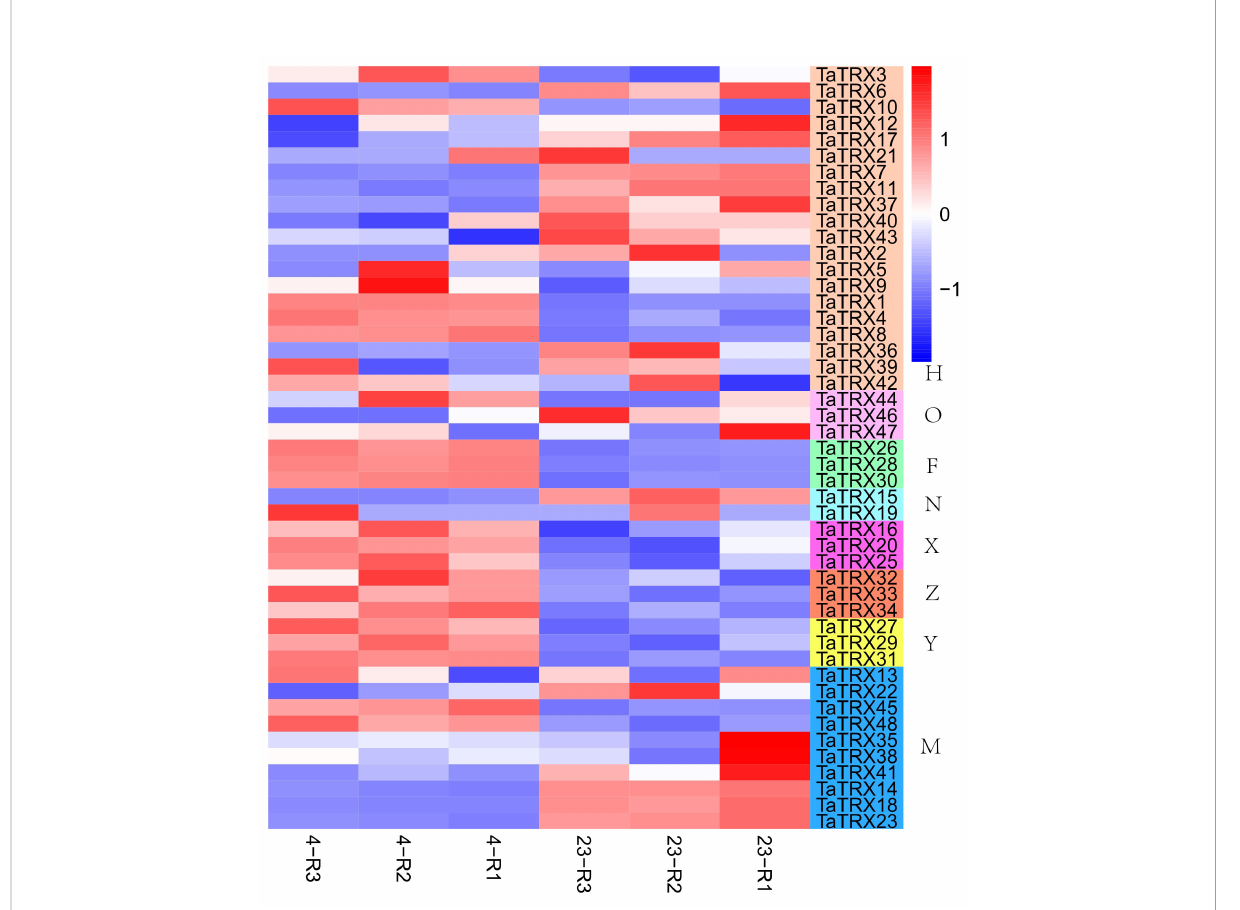
FIGURE 7 Expression pro fi les of typical TaTRX genes in wheat before and after cold stress. 23 represents wheat without cold stress treatment; 4 represents wheat treated by 4°C cold stress. The red, white and blue cells represent the highest, medium and lowest gene expression levels, respectively. H, O, F, N, X, Z, Y, and M represent different subtypes of typical TaTRX genes, respectively. The colour scale represents Log2 expression